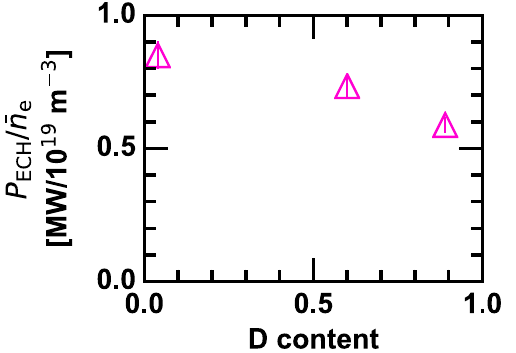
Figure 2. Deuterium content dependence of the threshold value of ECH power normalized by the line averaged density for the ITB